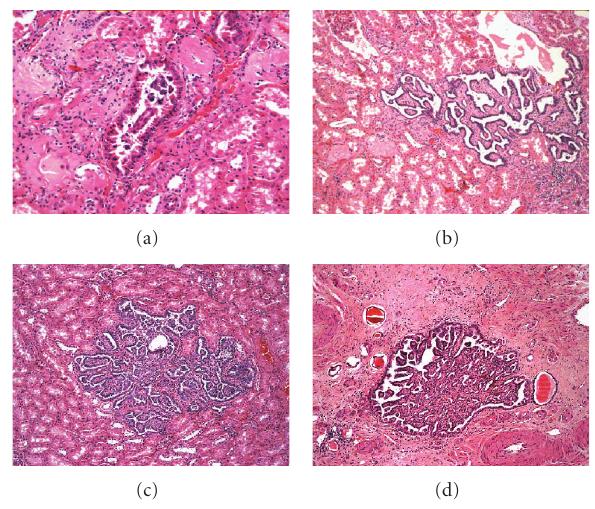
Figure 2: Papillary adenomas: di ff erent types of basophilic cell